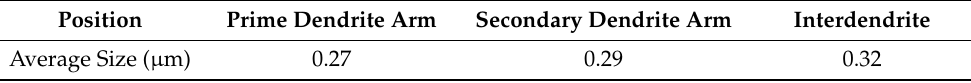
Figure 11. The γ ’ phase size distribution in the typical region of the single crystal blade section. ( a ) Primary dendrite arm, ( b ) Secondary dendrite arm, ( c ) Interdendrite. Table 3. The average size of the γ ’ phase extracted at different positions of the single crystal